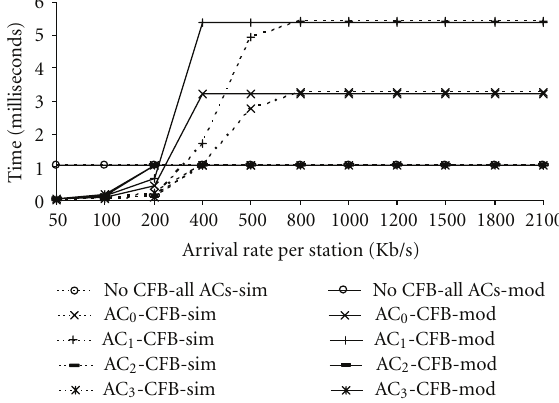
Figure 9: Transmission time, previous models, our model, simula-